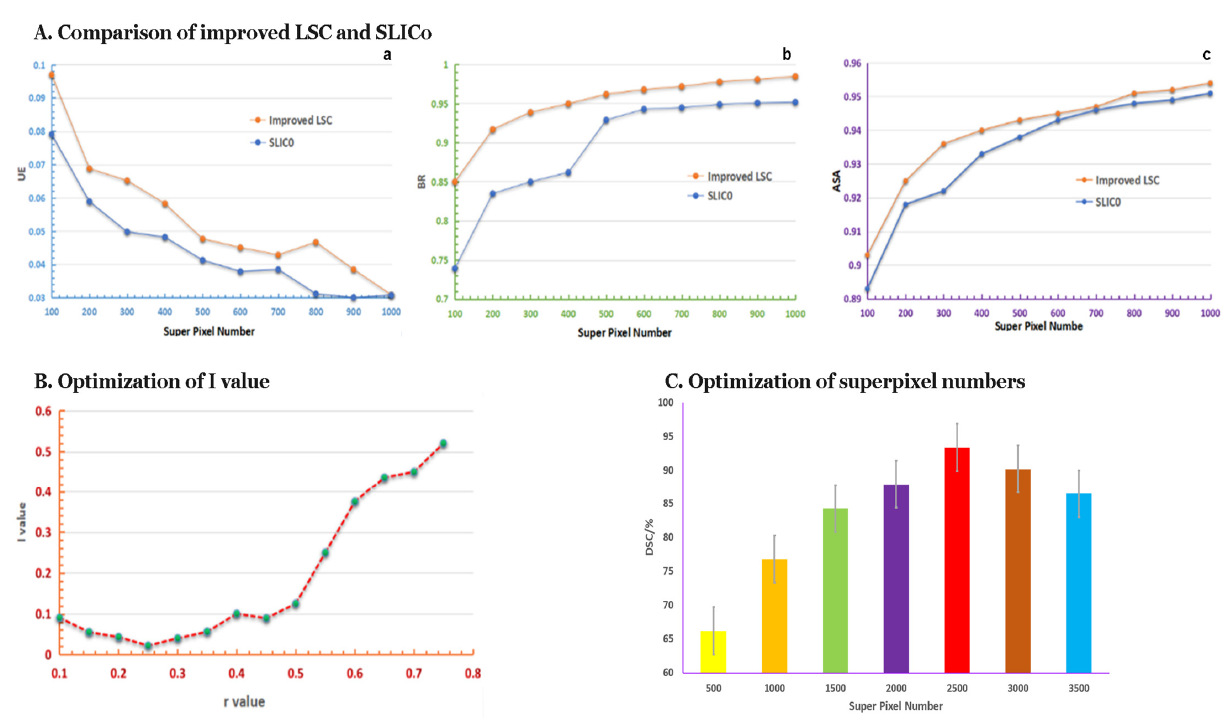
Figure 5. Variation of different numbers used in improved LSC and the segmentation results of MRI imaging. ( A ) Comparison between the improved LSC and SLIC0 with superpixel segmentation indexes; a, b, and c are the comparison of UE, BR and ASA, respectively. ( B ) The minimum I value was set at r = 0.25. ( C ) Evaluation of the best superpixel number for segmentation. The highest DSC was acquired when the superpixel number reached 2500.